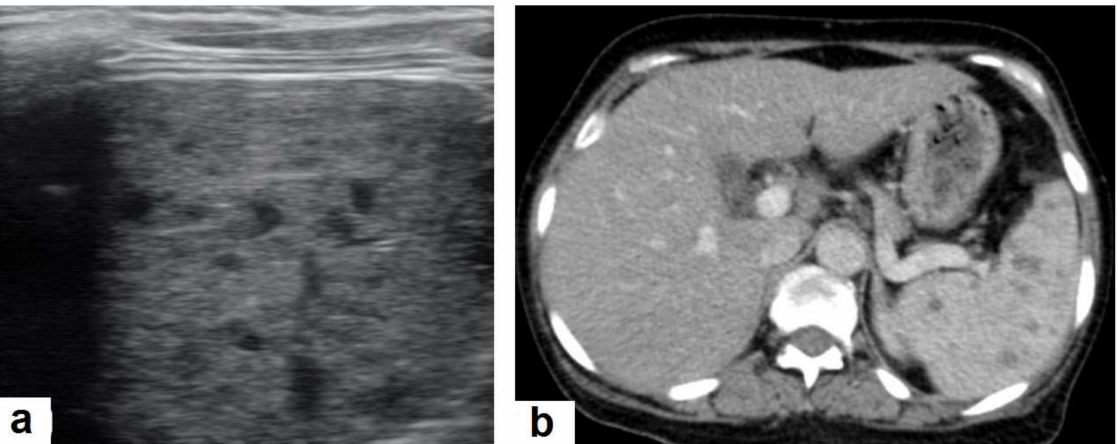
Figure 7. Miliary TB in an adult female with fatigue and loss of appetite. ( a ) Splenic ultrasonography shows multiple small hypoechoic granulomas with random distribution in the spleen. ( b ) Axial abdominal CT shows small non-enhancing granulomas with random distribution in the spleen clearly seen during the portal venous phase with multiple enlarged lymph nodes around the portal